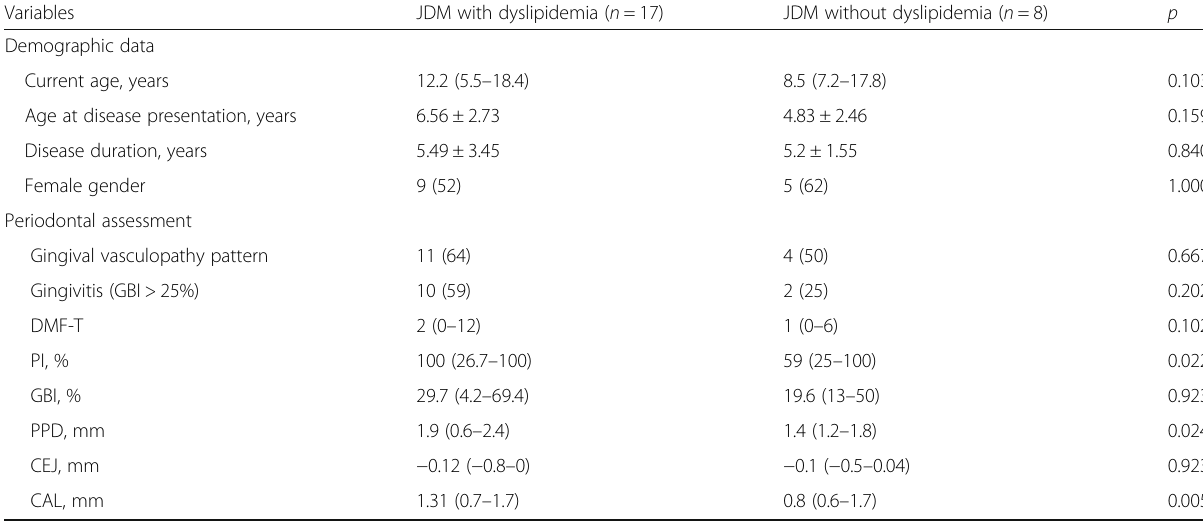
Table 2 Demographic data and periodontal assessment in juvenile dermatomyositis (JDM) patients with and without dyslipidemia